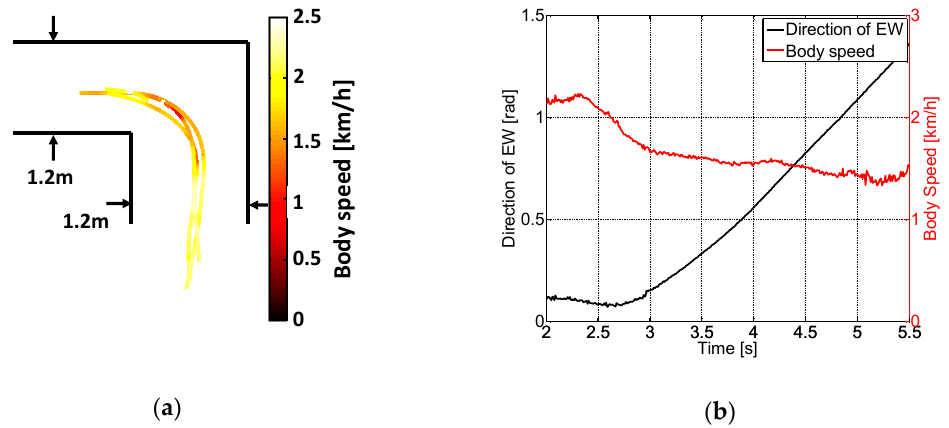
Figure 9. Experimental results of the driving characteristics: ( a ) trajectories and body speeds and ( b ) motion of an EW.